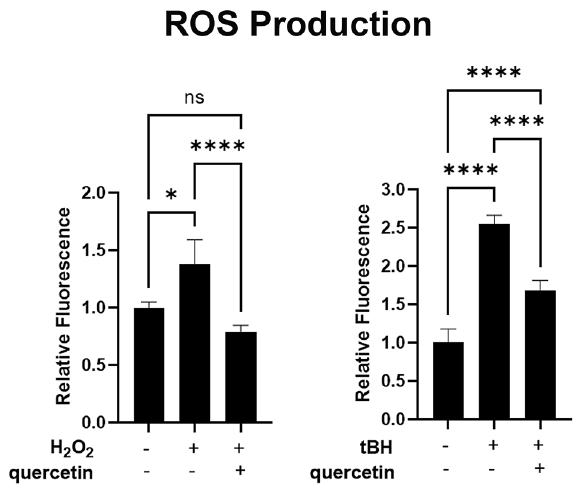
Figure 3. Reactive Oxygen Species (ROS) production after oxidative stress in iPSC-RPE. Graph shows relative fluorescence detection after iPSC-RPE are exposed to either 800 µM H 2 O 2 or 1 mM tBH, with or without pre- treatment with 400 µM quercetin, using Carboxy-H 2 DCFDA as a fluorescent cell-permeant indicator of ROS. For the H 2 O 2 experiments, n = 12 for the H 2 O 2 group and n = 6 for the control group and the H 2 O 2 + quercetin group. For the tBH experiments, n = 5 for all groups. All replicates were biologic; there were no technical replicates. Results were analyzed by Kruskal–Wallis for the H 2 O 2 experiments due to unequal sample size, and by one-way ANOVA for the tBH experiments. *p < 0.05, ****p < 0.0001, ns = not